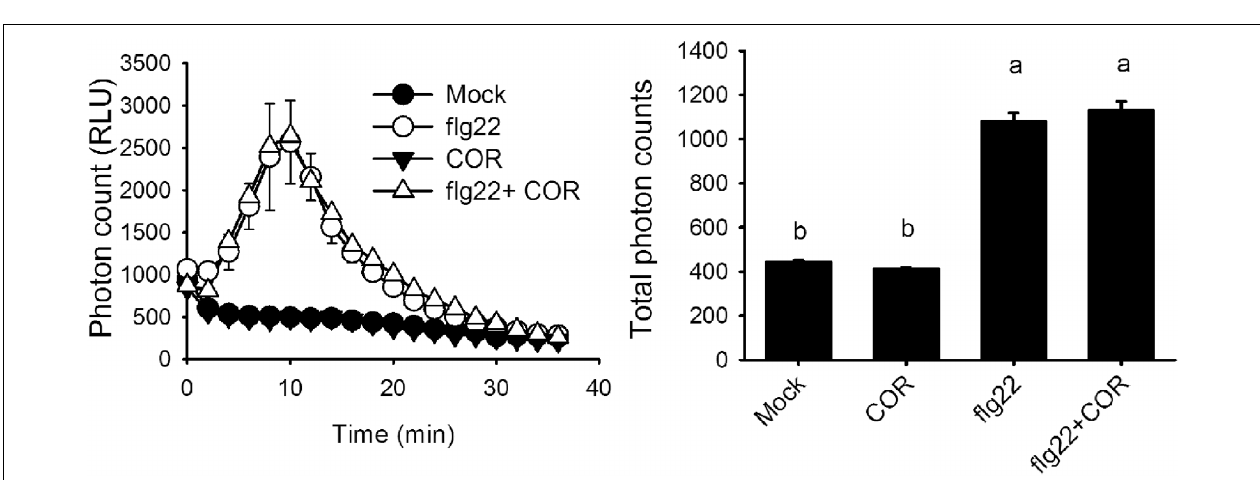
FIGURE 2 | Coronatine does not affect ROS induction by flg22 in leaf disks. Coronatine (COR, 1.56 µ M) did not prevent ROS induction by flg22 (1 µ M) in leaf disks. ROS were measured by the peroxidase luminol enhanced chemiluminescence method and are expressed as relative light units (RLU). Values are averages of total photon counts from each treatment. Different letters indicate significant differences at p < 0.01 (one-way ANOVA, Tukey’s test). Error bars represent SE from three independent trials, n = 12 per